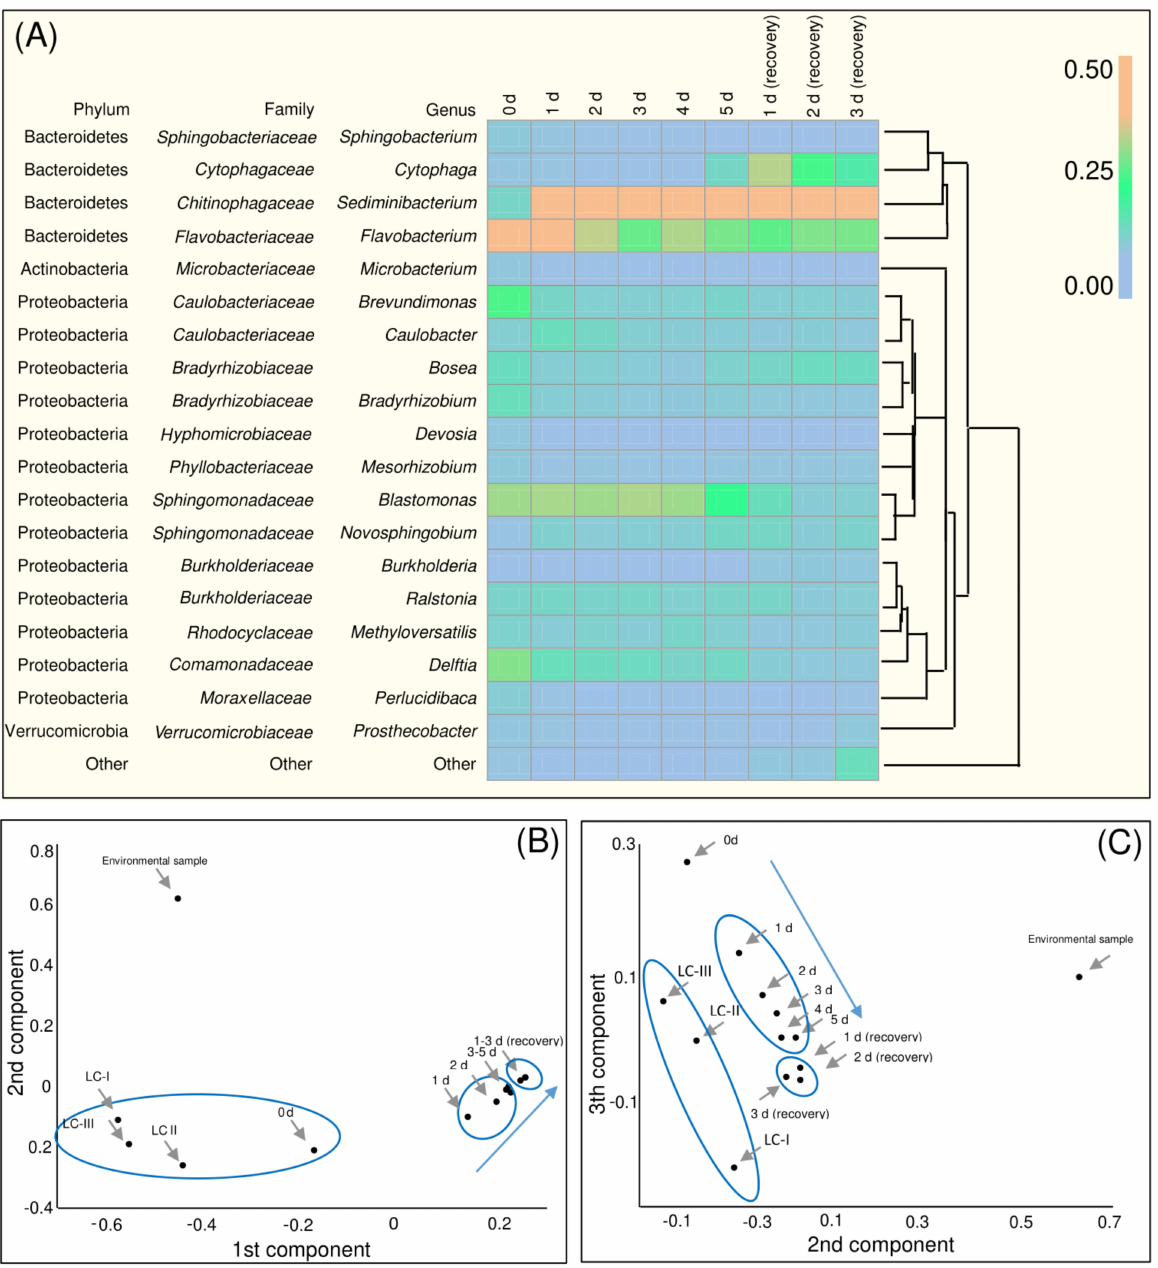
Figure 3. ( A ) Heatmap of bacterial taxa abundant in the samples of H. lacustris associations painted based on the fraction of NGS reads corresponding to each genus. Color scale corresponds to fraction of reads. The taxa with NGS reads fraction < 1% were not considered. The phylogenetic relationship of taxa was reconstructed by a neighborhood joining algorithm. The results of the principal component analysis (PCA) based on the matrix of Morisita–Horn indices for each sample pairs ( B ) projection of the space of three components on the plain of the 1st and 2nd components and ( C ) on the plain of 2nd and 3rd components. LC-I, LC-II, LC-III (the laboratory H. lacustris cultures maintained after isolation from environment, see Material and Methods) and ‘environment sample’ are datasets from [26]. Blue arrows reflect the experiment time. In general, H. lacustris cultivated in a photobioreactor was characterized by a